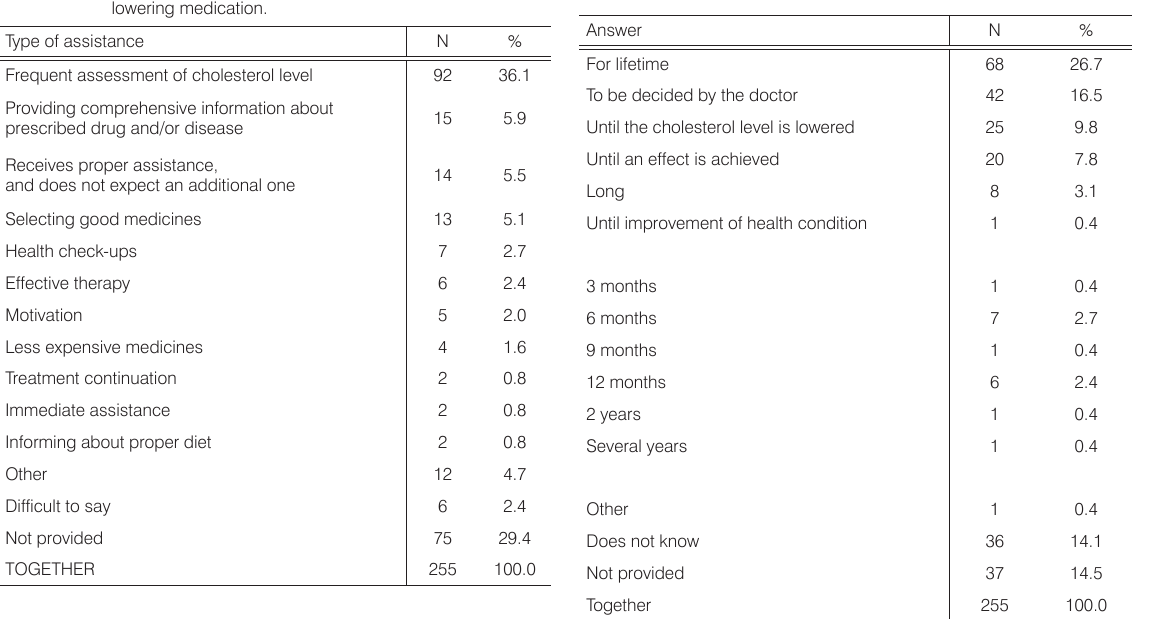
Table 6. Opinions on how long the lipid-lowering treatment should be